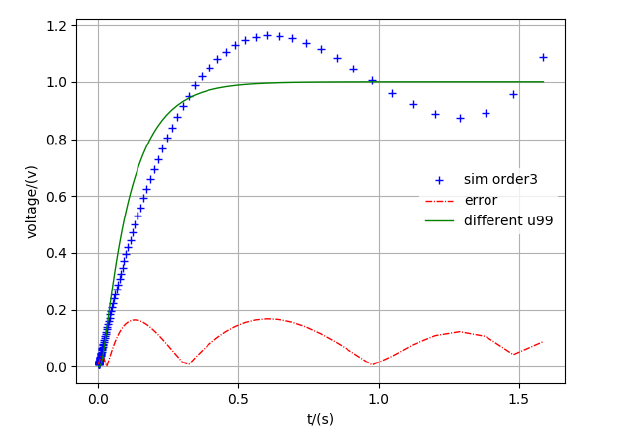
Figure 4. Simulation three-order.